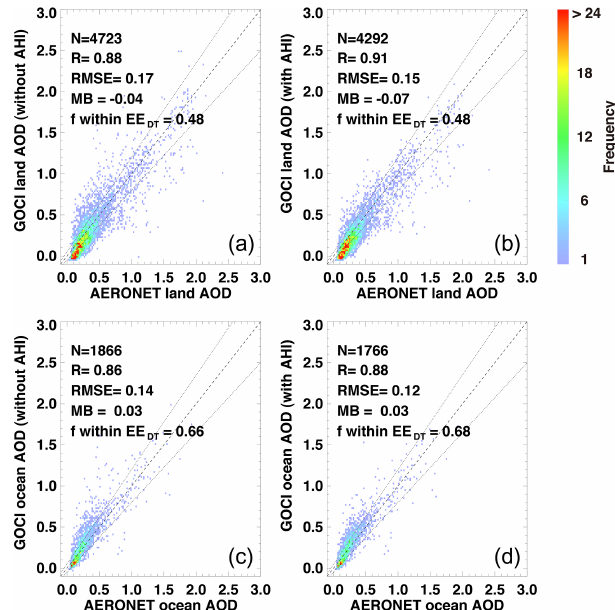
Figure 2. Comparison of AERONET AOD and (a) GOCI land AOD without additional cloud masking, (b) GOCI land AOD with ad- ditional cloud masking, (a) GOCI ocean AOD without additional cloud masking, and (b) GOCI ocean AOD with additional cloud masking using AHI IR channels. Black lines indicate zero differ- ence and the EE DT range ± ( 0 . 05 + 0 . 15 × AOD AERONET